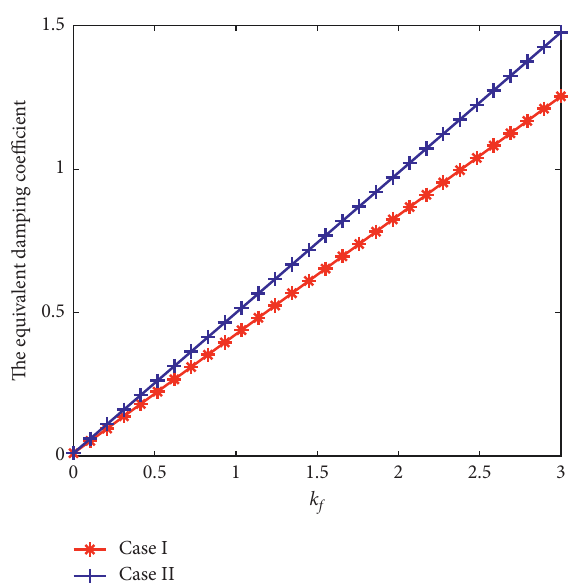
Figure 38: The equivalent damping coefficients versus rotating speed for cases I and